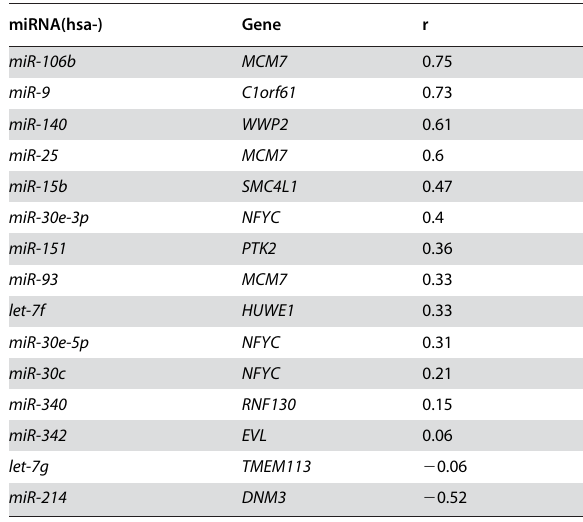
Table 2. Correlations between intronic miRNAs and their